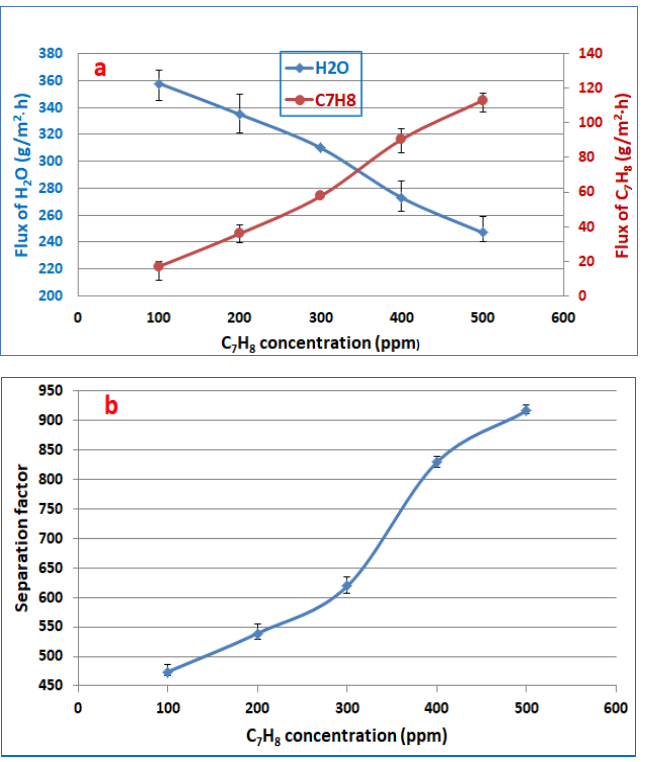
Figure 3. Effect the toluene feed concentration on ( a ) fluxes of toluene and water, ( b ) separation factor, at feed temperature of 30 °C and 3 L/min feed flowrate. 3.3. Effect of Feed Flowrate on the Toluene Partial Flux Figure 4 shows the effect of the feed flowrate on fluxes of toluene and water and the separation factor of the PDMS membrane at 300 ppm toluene feed concentration and 30 °C feed temperature. It can be noticed that the toluene partial flux improved from 26 to 74 g/m 2 ·h with an increase in the feed from 1.5 to 3.5 L/min. It was observed that the ef- fect of the flow rate on the flux of toluene was strong, may be attributed this observation to reduce the concentration polarization effect on toluene permeation in pervaporation after increasing the flow rate, besides the minor thickness of the active layer, which was about 5 µm. The boundary layer represents a major resistance for toluene transport in addition to the permeation resistance in the membrane, where the flux was inversely proportional to the active layer thickness of the membrane [46,47]. As a matter of fact, the boundary layer effect is significant, as the flow regime is close to laminar (i.e., Re =